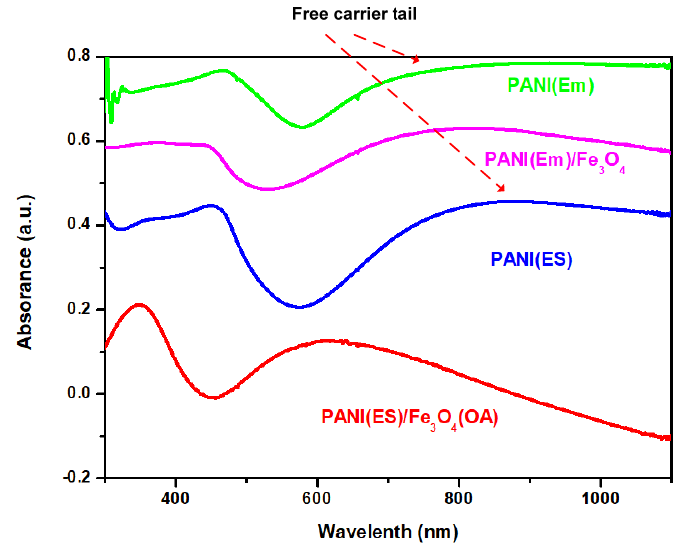
Figure 2. UV-Vis-NIR spectra of various PANIs.